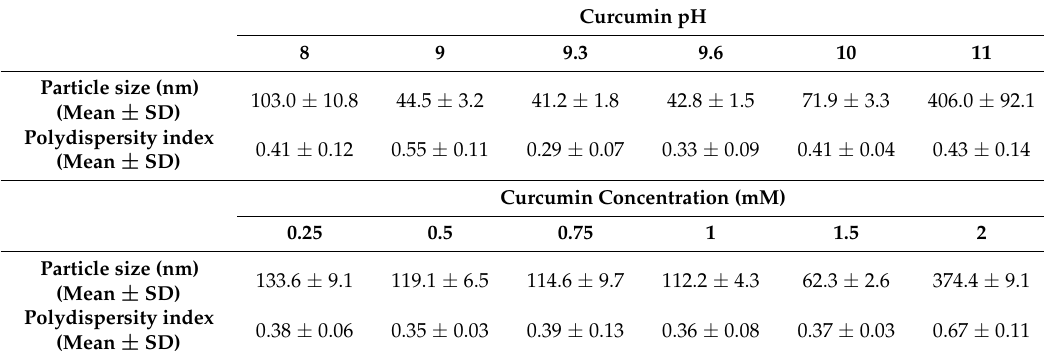
Table 1. Particle size of curcumin-gold nanoparticles obtained from different curcumin pH and concentration ( n = 3).